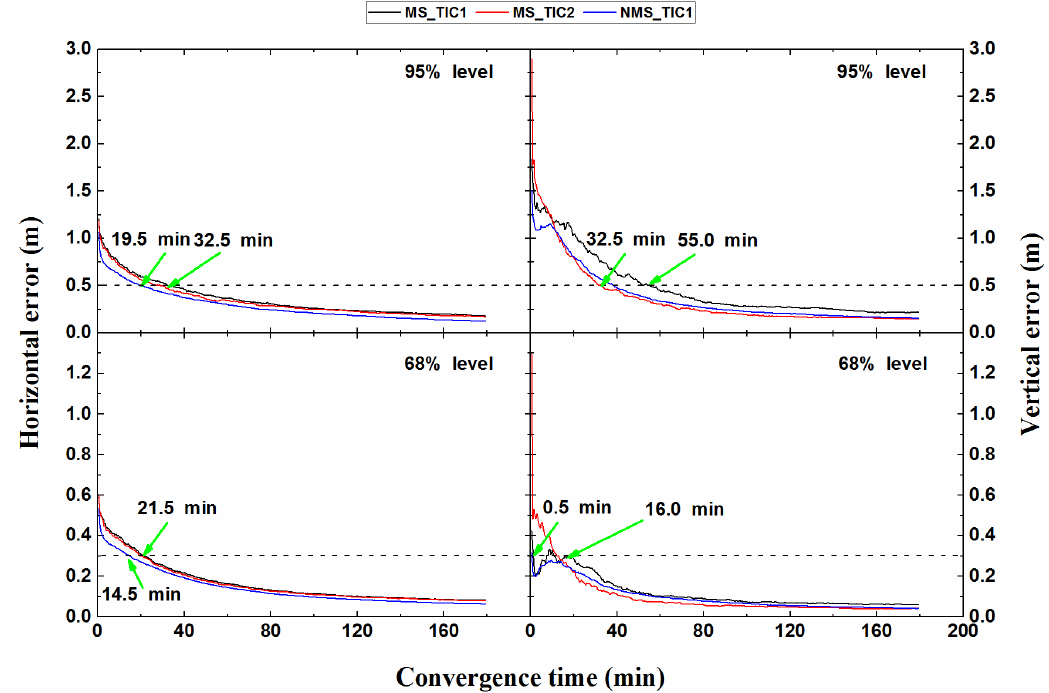
Figure 11. The GPS static SF PPP convergence performance in different constraint schemes during the MS and NMS periods.